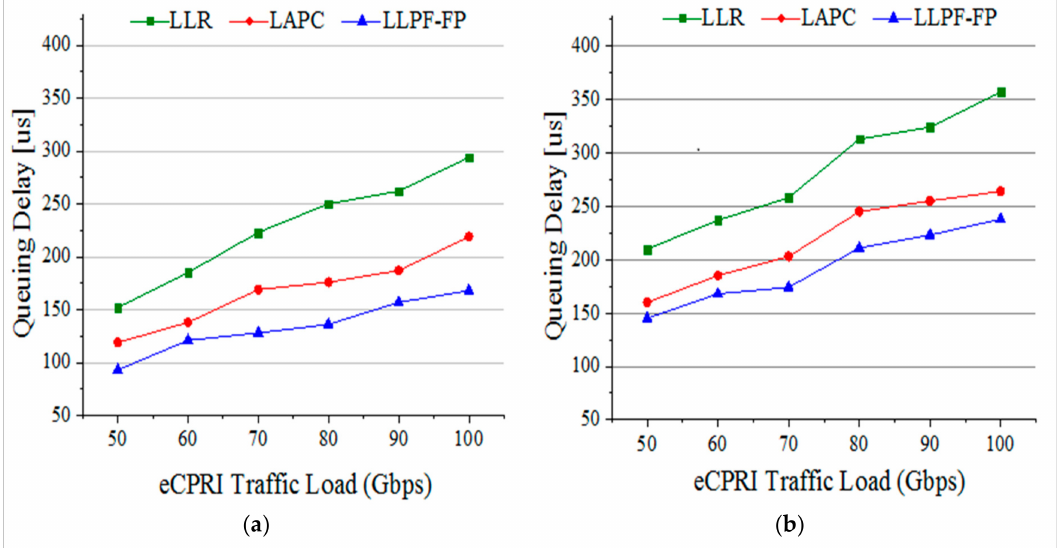
Figure 5. Performance results for average queuing delays for the ( a ) COST239; and ( b )